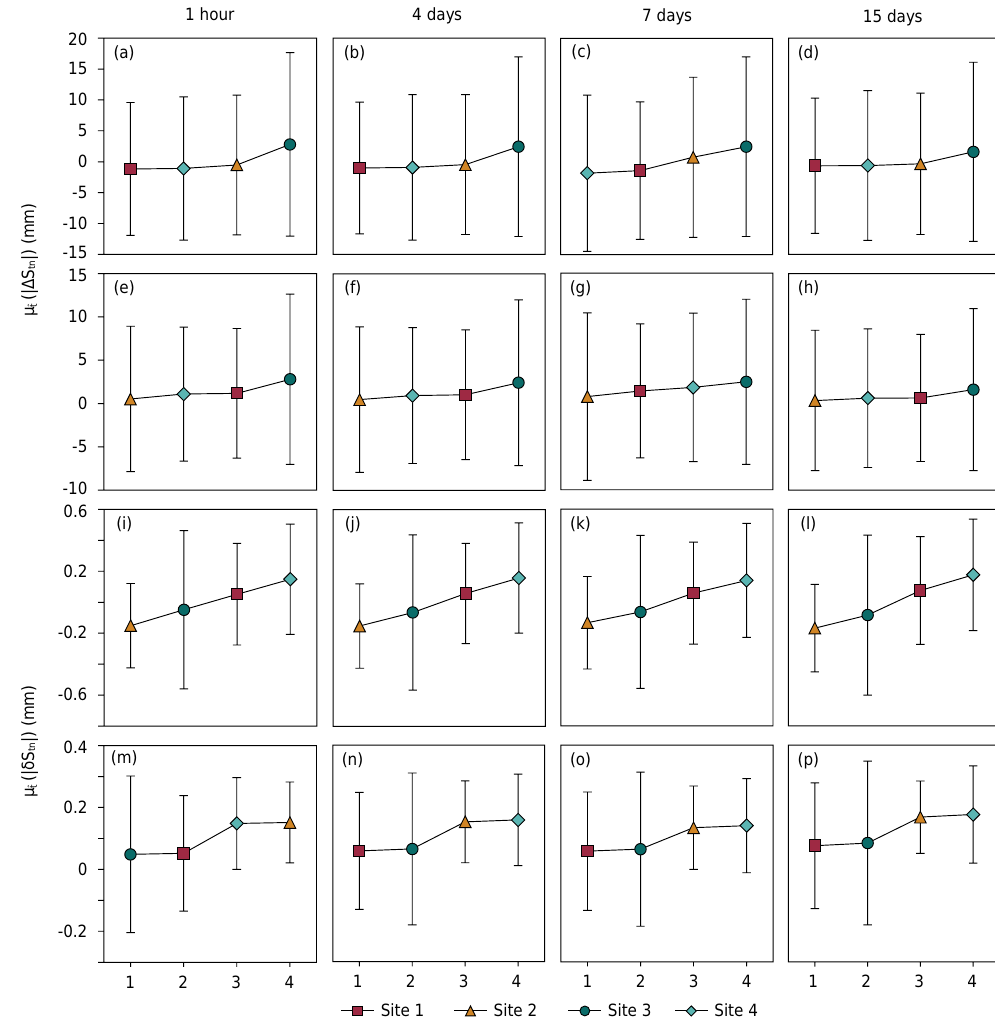
Figure 5. Ranking stability plots of temporal means of absolute Soil Moisture (SM) differences [μ t ̂ (ΔS tn )] (a, b, c, and d), absolute temporal means of absolute SM differences [|μ t ̂ (ΔS tn )|] (e, f, g), and temporal means of relative SM differences [μ t ̂ (δS tn )] and absolute temporal means of relative SM differences [|μ t ̂ (δS tn )|] (i, j, k, and